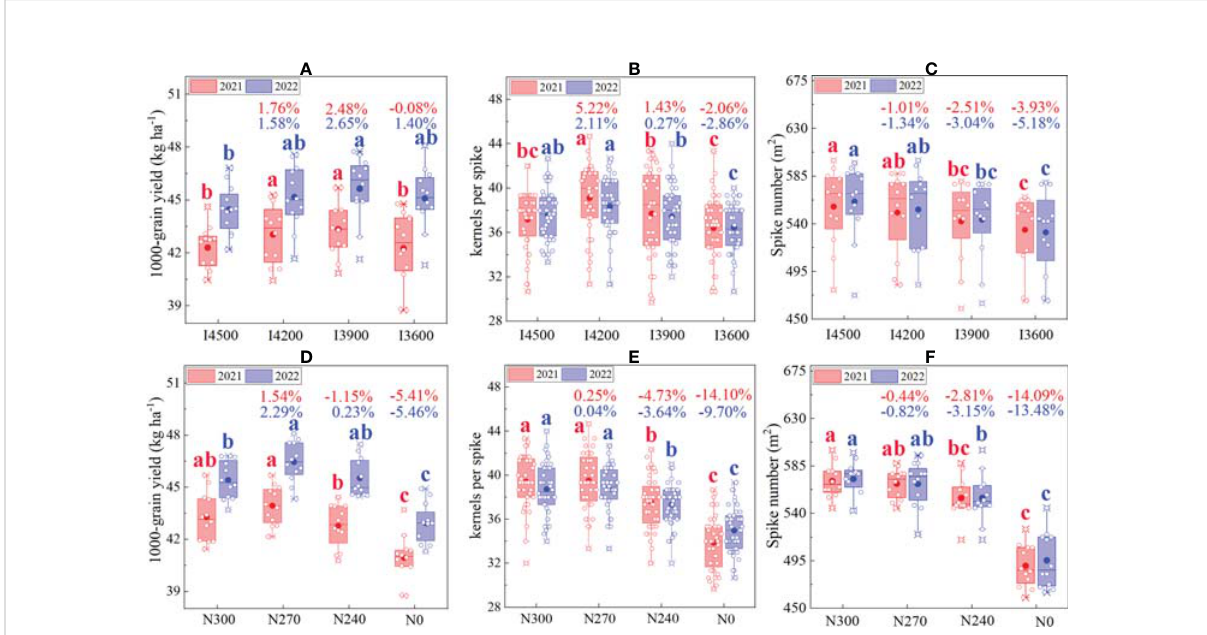
FIGURE 3 Effects of irrigation and nitrogen levels on wheat yield components (1000-grain weight, kernels per spike, and spike number). (A – C) represent the performance of 1000-grain weight, kernels per spike and spike number under different irrigation levels; (D – F) represent the performance of 1000-grain weight, kernels per spike and spike number under different nitrogen levels, respectively. I4500, I4200, I3900, and I3600 indicate 4500, 4200, 3900, and 3600 m 3 ha − 1 irrigation levels, respectively. N300, N270, N240, and N0 indicate 300, 270, 240, and 0 kg ha − 1 nitrogen levels, respectively. The numbers in the columns indicate the percentage change in yield components (1000-grain weight, kernels per ear, and spike number) under a given treatment compared with conventional irrigation (I4500) and nitrogen levels (N300). The lowercase letters refer to signi fi cant differences among the treatments at the 0.05